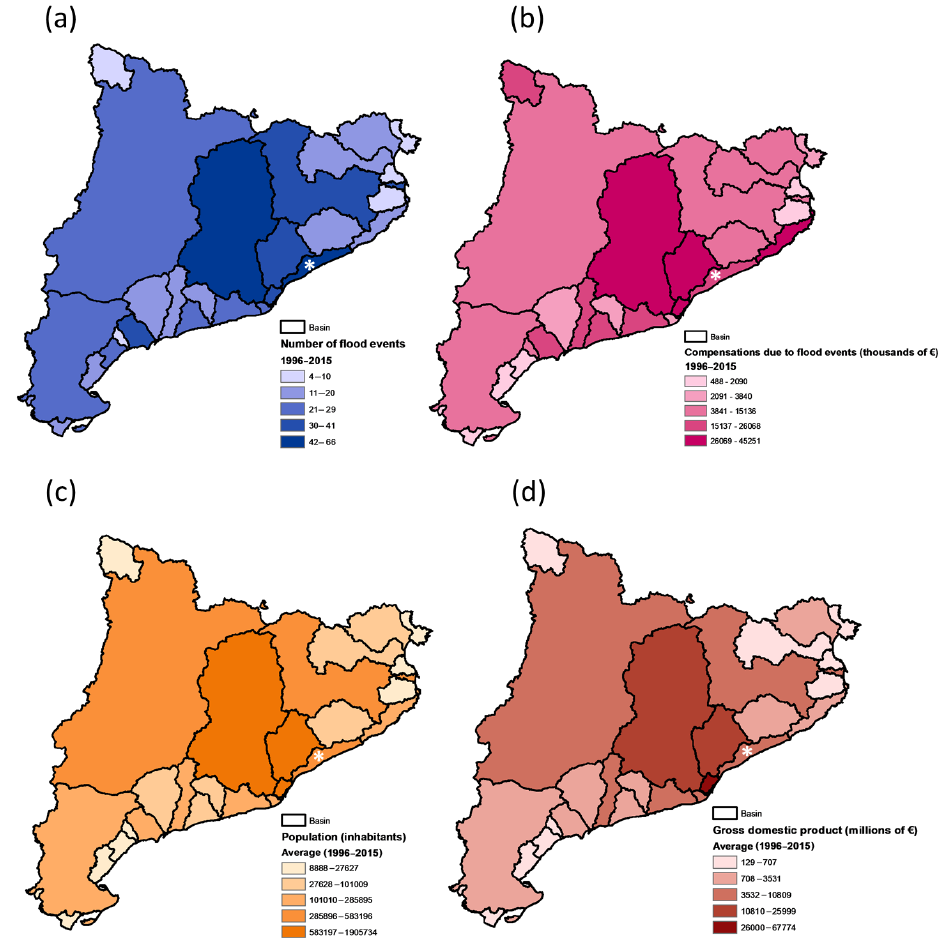
Figure 3. Basin distribution of (a) flood events (1996–2015), (b) total insurance compensation for floods made by CCS (1996–2015), (c) average total population, and (d) average GDP. Asterisk indicates Maresme